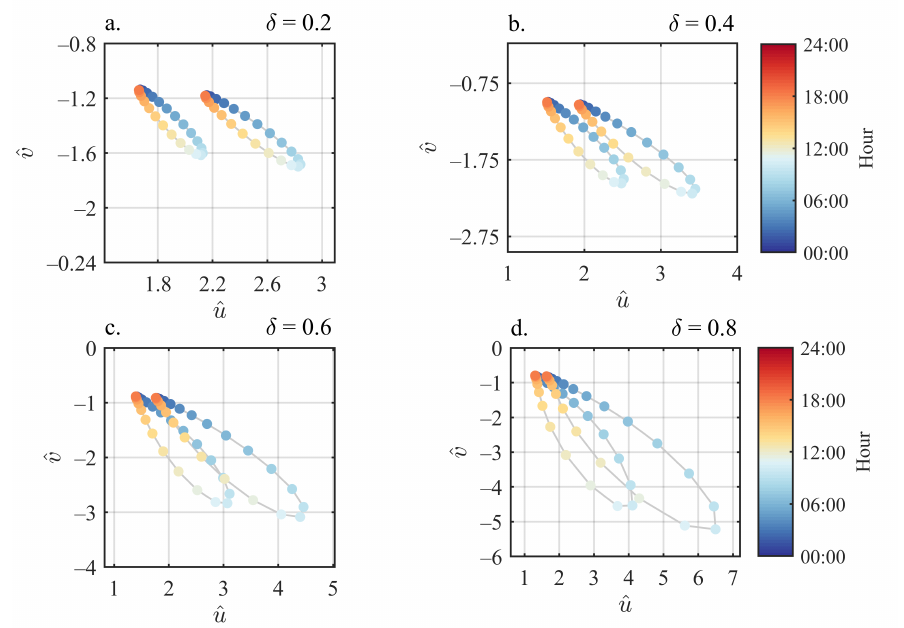
Figure 11. Diurnal cycle of surface two-layer velocity at latitude 45°N under ( a ) δ = 0.2, ( b ) δ = 0.4, ( c ) δ = 0.6, ( d ) δ = 0.8, and the large circle in each panel stands for the velocity circle at z = − 1 m, while the smaller one stands for the velocity at z = − 2 m. The color scale indicates different hours of the day. All the velocities are normalized the same as in Figure